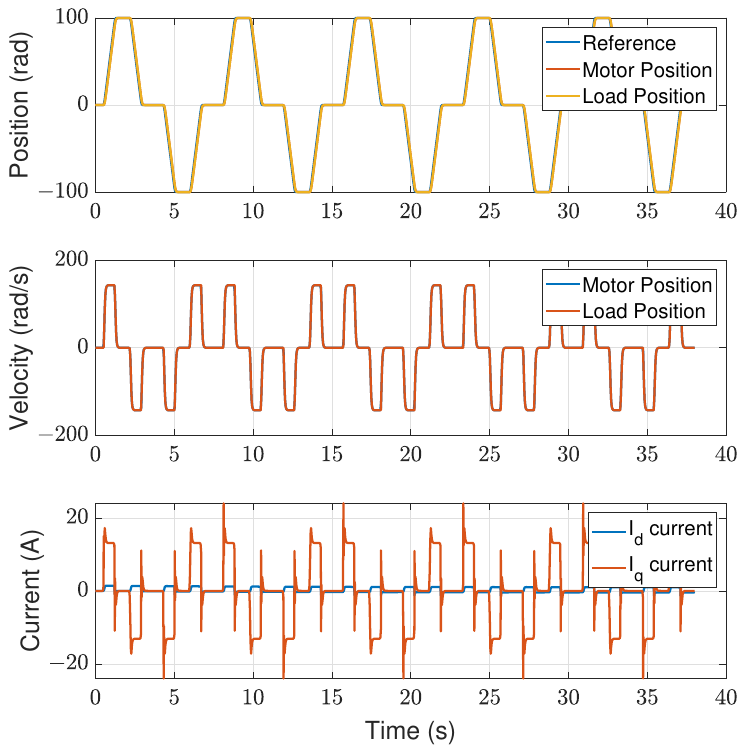
Figure 7. Controlperformance without the backlash compensation.